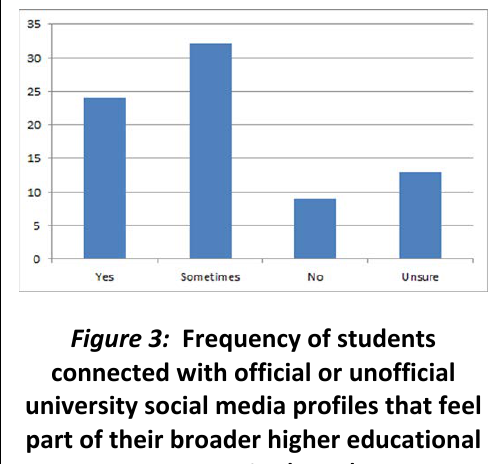
Figure 3: Frequency of